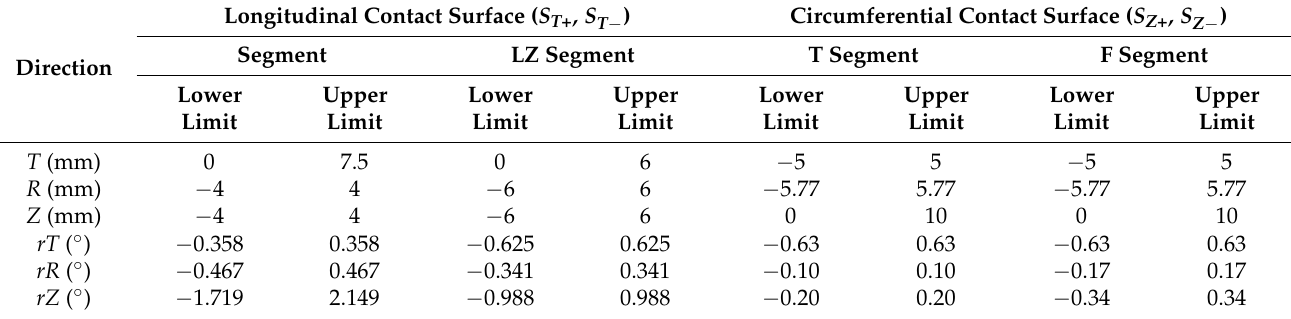
Table 1. Displacement range of the contact